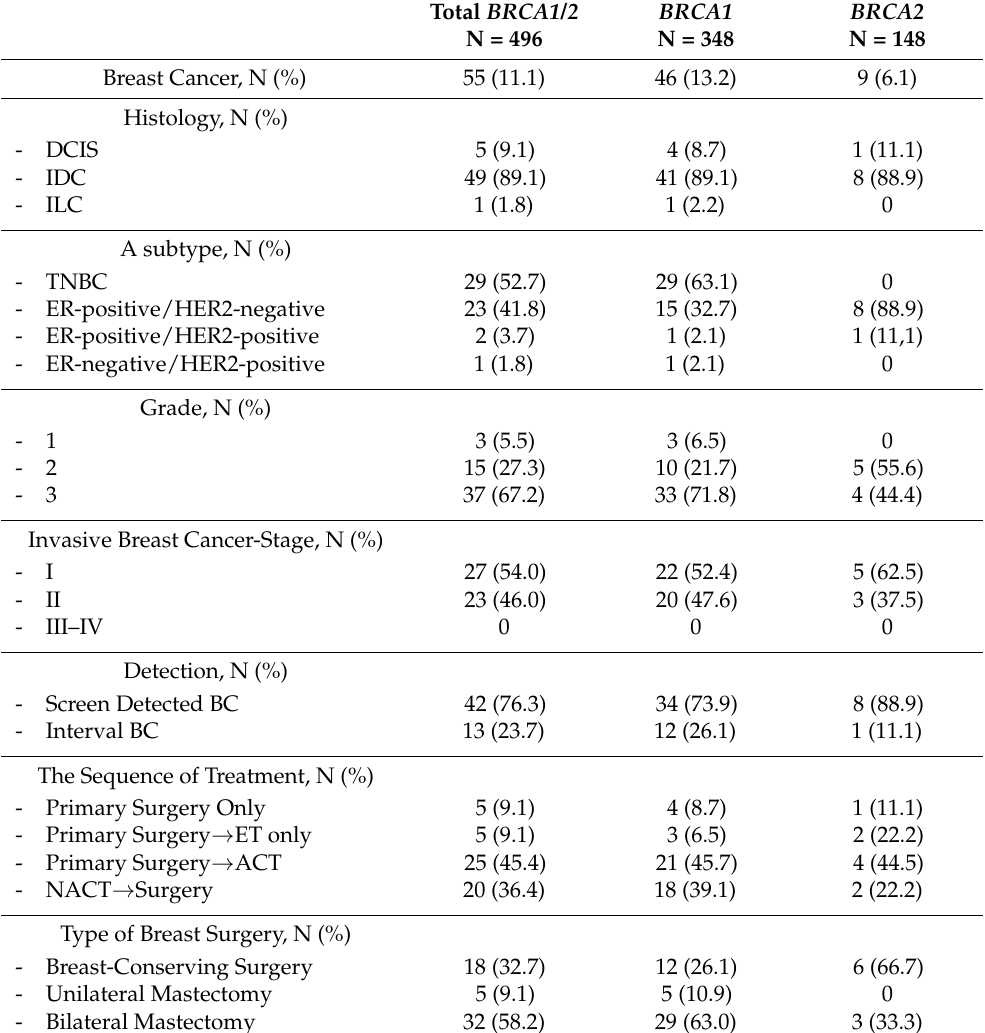
Table 3. Characteristics and Treatment of Breast Cancer (BC) in BRCA1/2